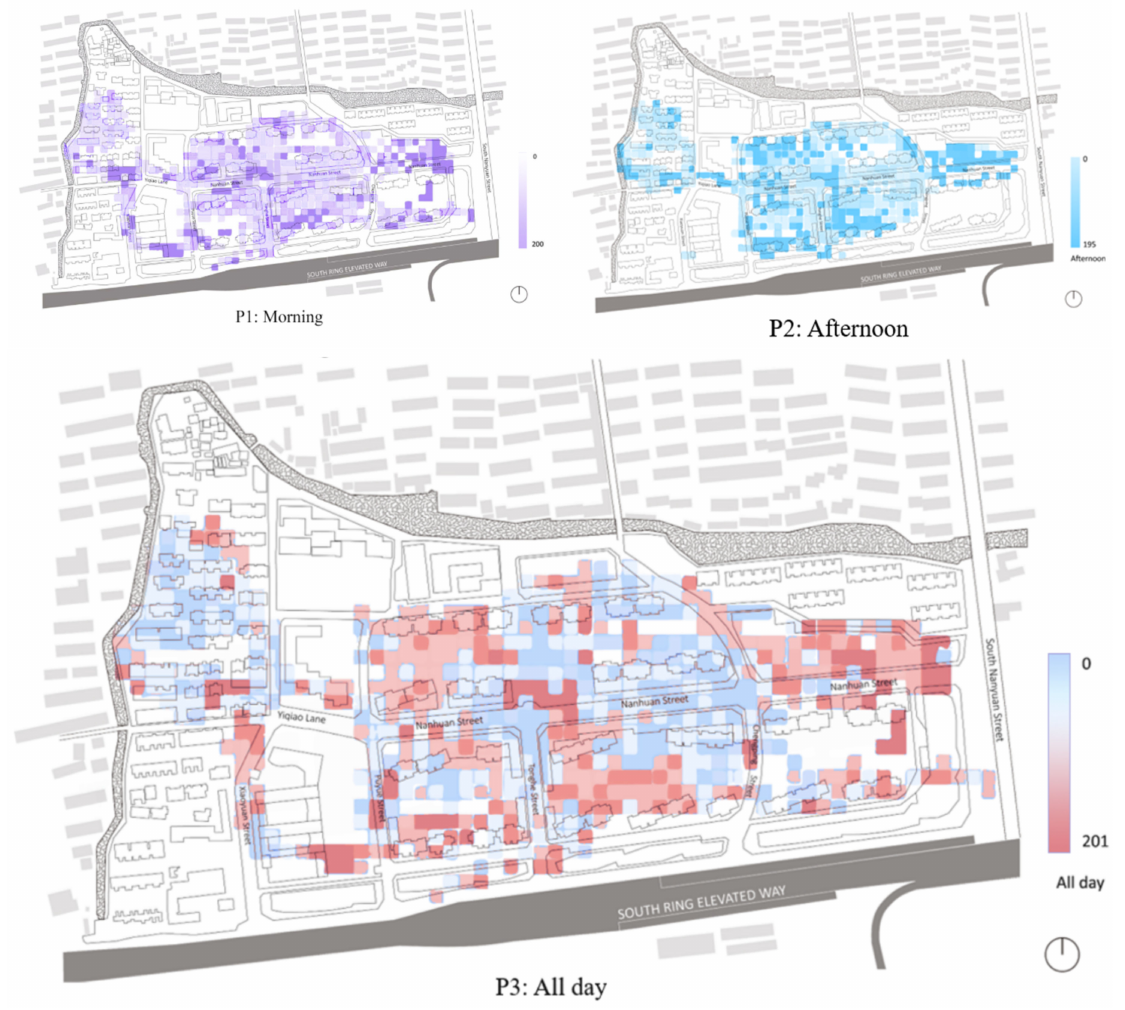
Figure 8. Distribution map of pedestrian